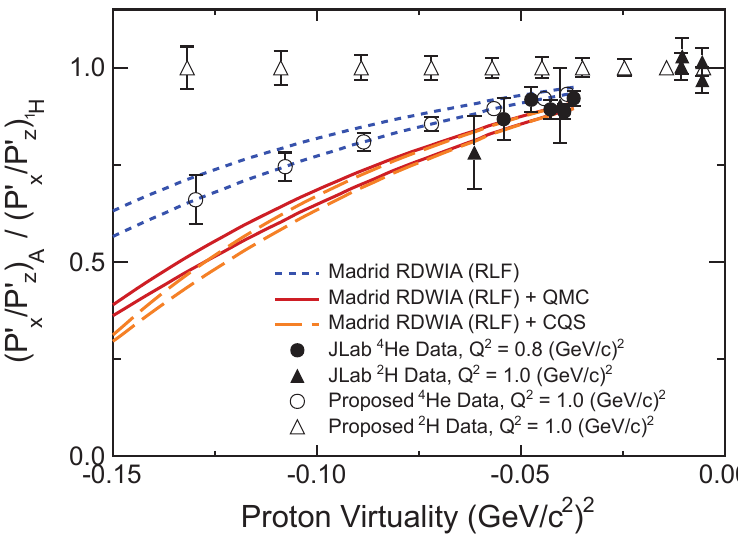
Fig. 4. Polarization-transfer double ratio in the 4 He( e , e (cid:2) p ) 3 H and 2 H( e , e (cid:2) p ) n reactions The curves are various calculations using the Madrid RDWIA model for the reaction on 4 He and current operators cc 1 (lower set of curves) and cc 2 (upper set of curves). The points indicate existing data [23,26] (solid symbols) and the statistical uncertainties of the expected data from E12-11-002 [39] which are arbitrarily placed on the RDWIA ( cc 1) curve for 4 He and at R = 1 for 2